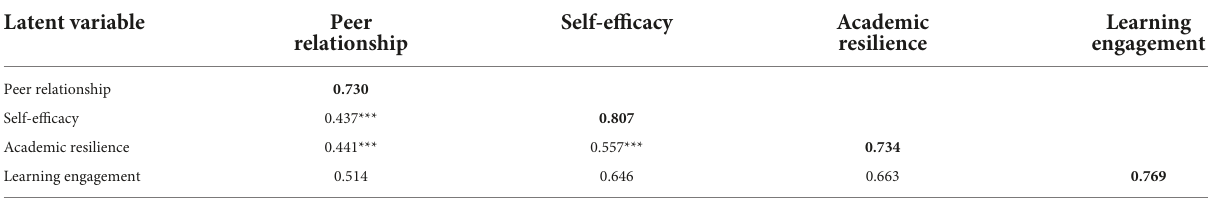
TABLE 4 The discriminate validity test of latent